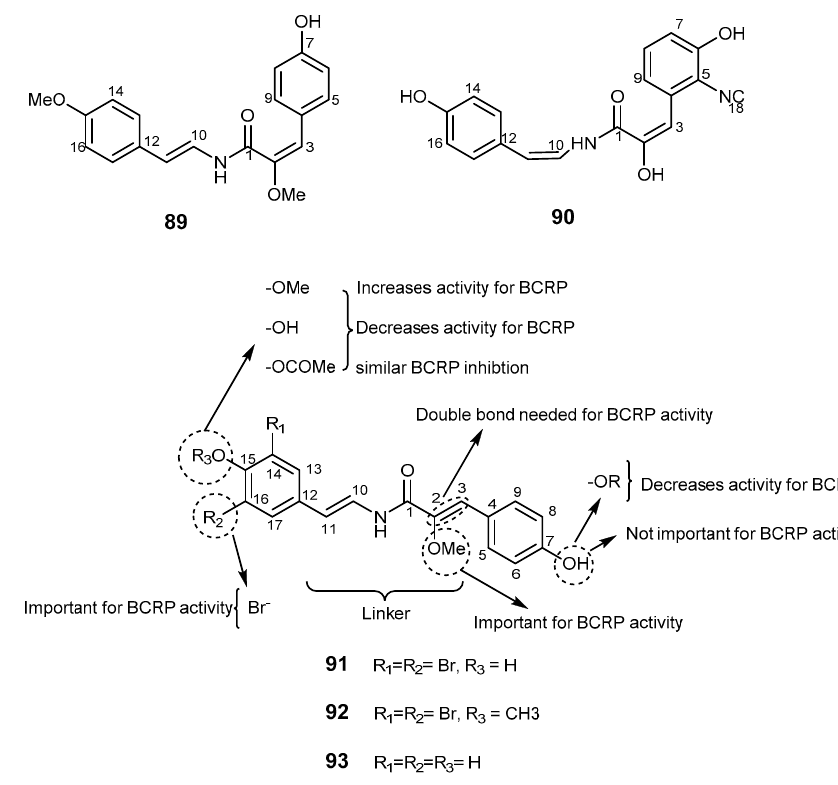
Figure 18. Botryllamides 89 – 93 and SAR studies on BCRP inhibitory activity.